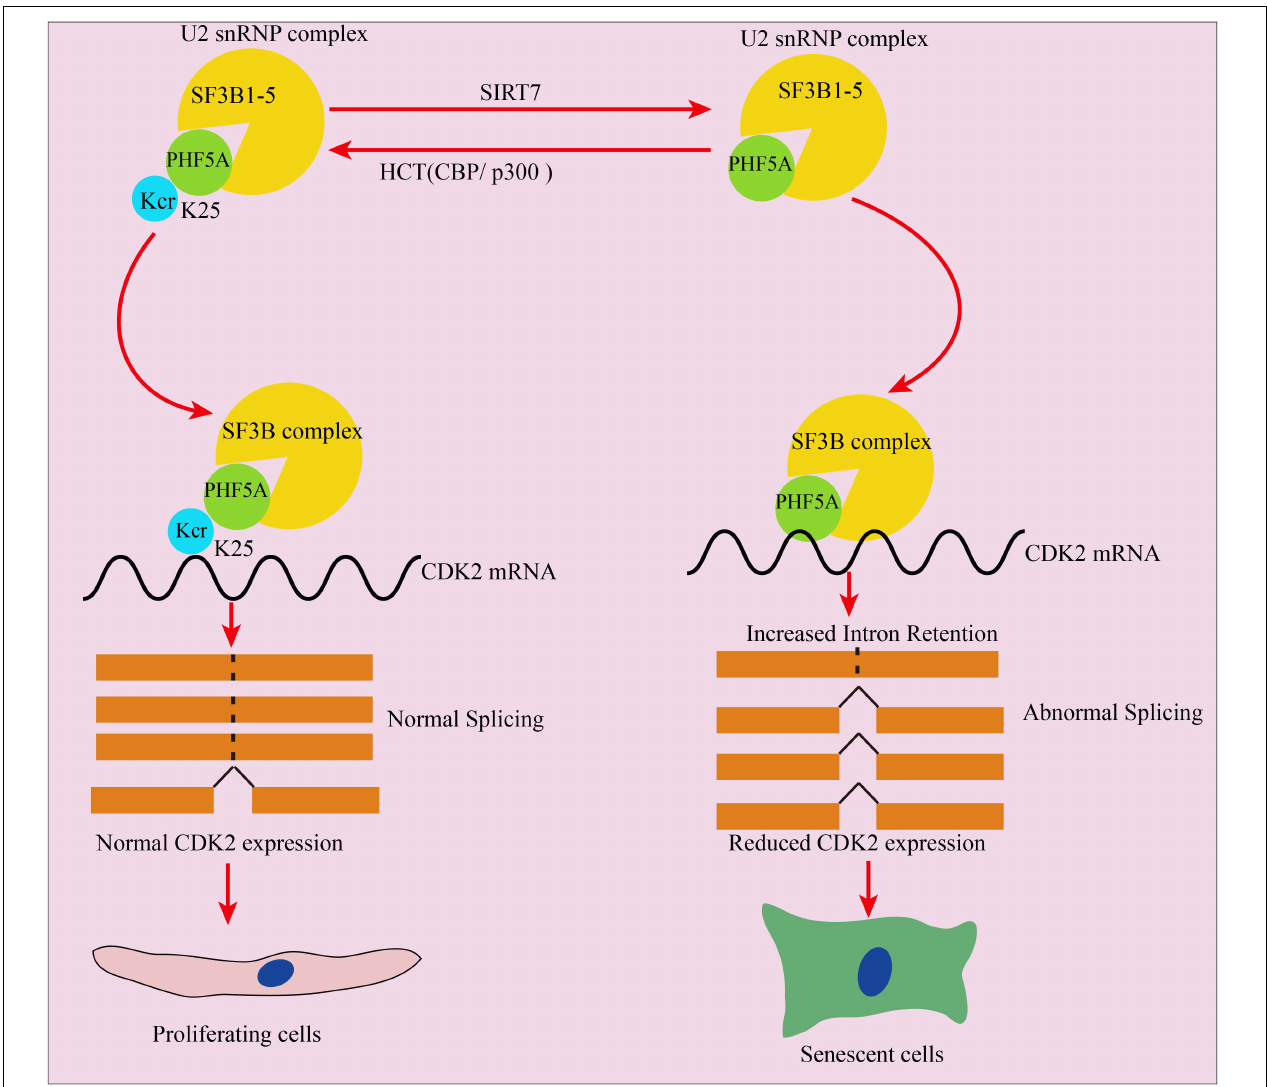
FIGURE 8 | Schematic illustration of PHF5A decrotonylation at K25 by SIRT7 regulates aging progress through alternative splicing mediated downregulation of CDK2. PHF5A could be decrotonylated and crotonylated at K25 by SIRT7 and CBP/p300, respectively. Decrotonylation of PHF5A at K25 reduced downstream target CDK2 mRNA and protein expression through RI-induced alternative splicing, and thereby accelerating cellular